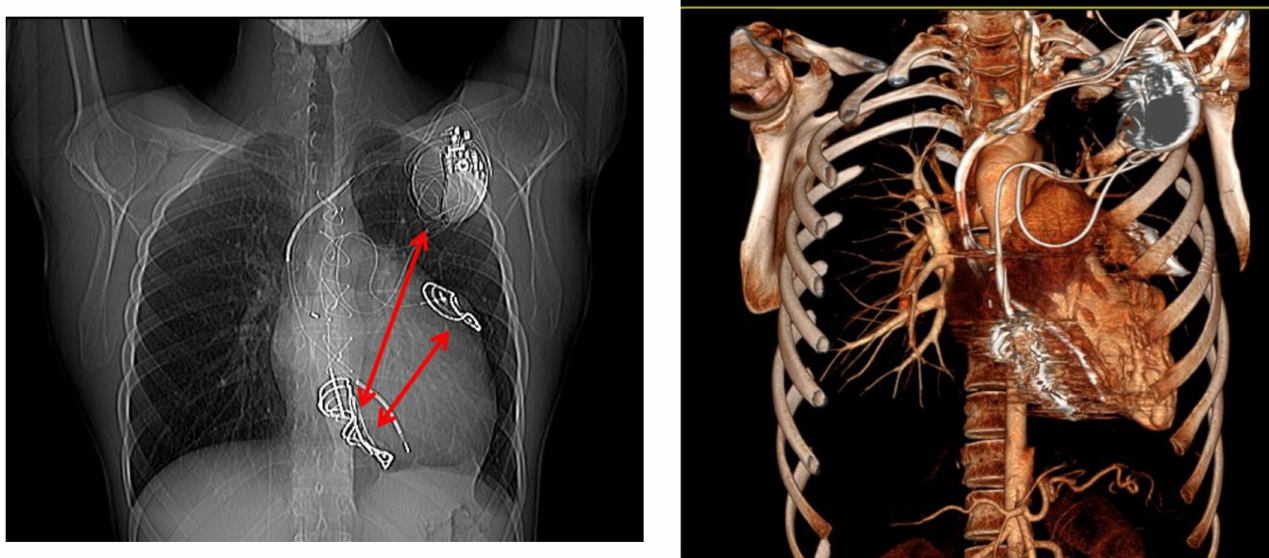
Figure 2. Left panel. AP chest X-ray showing dual-chamber ICD connected to two epicardial patches (lateral and inferior). The defibrillation pathway is between the two patches and the can (red arrows). Figure 2 right panel. CT scan shows strong adhesion of the patches with the underlying